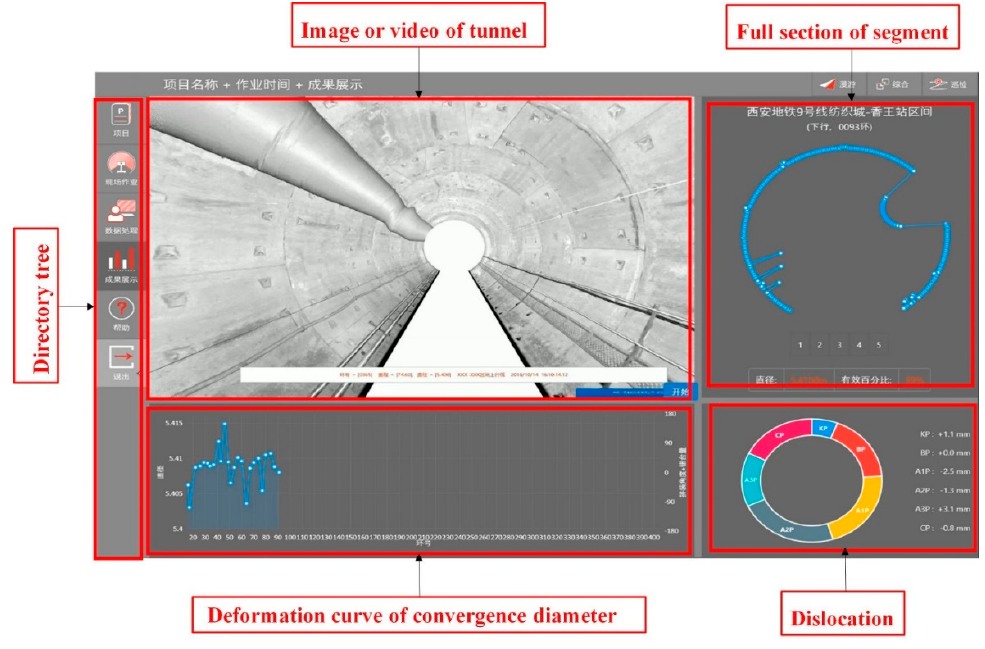
Figure 4. Monitoring center interface.